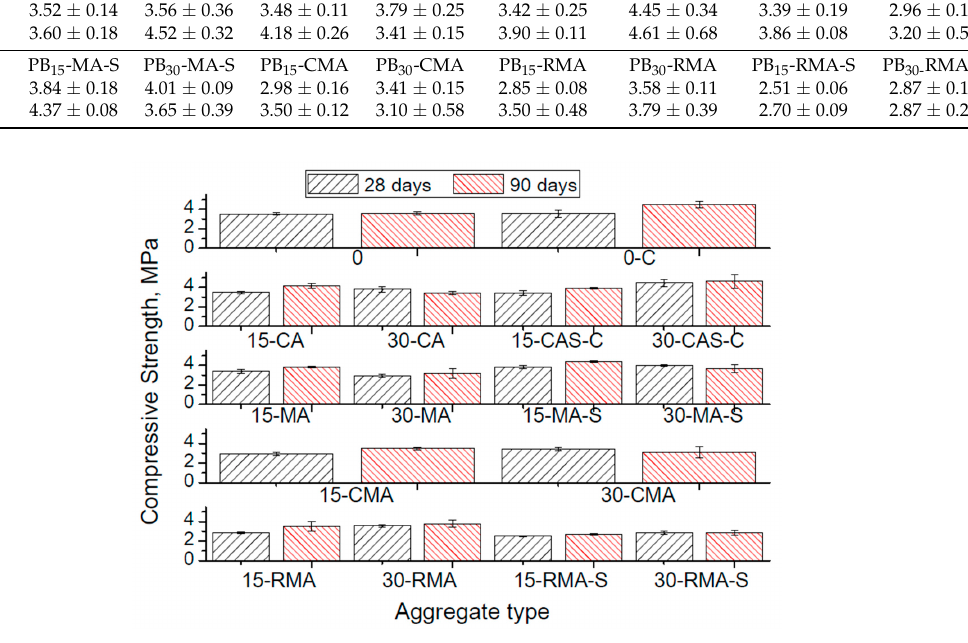
Figure 4. Results of mechanical strength in paving blocks, as a function of the aggregate type and dosaging method (see Table 5 for nomenclature).